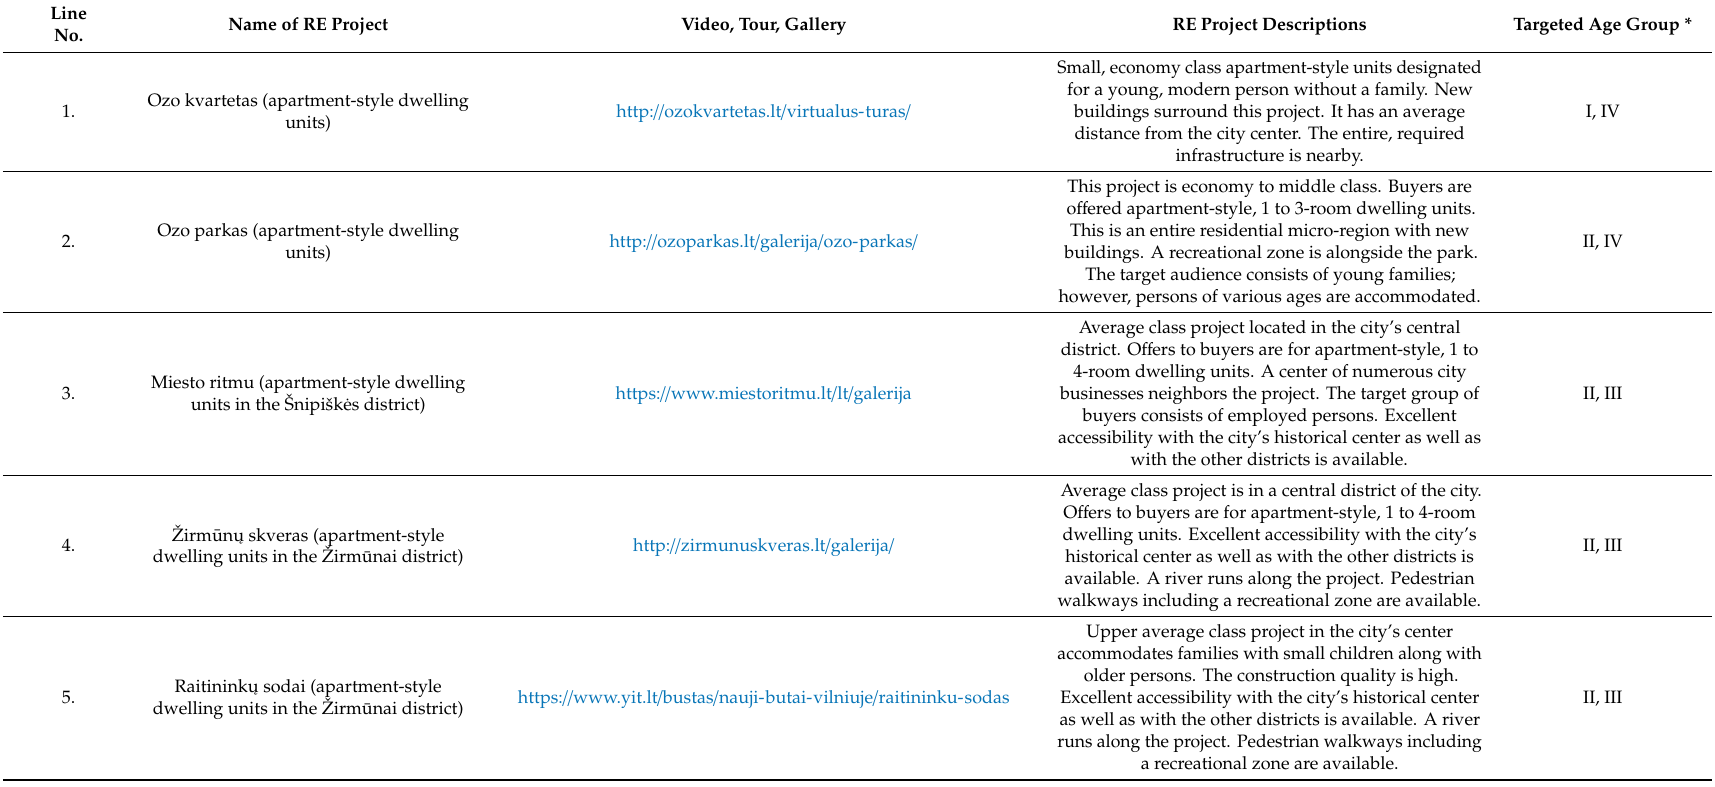
Table A1. Video advertisements on housing units and their